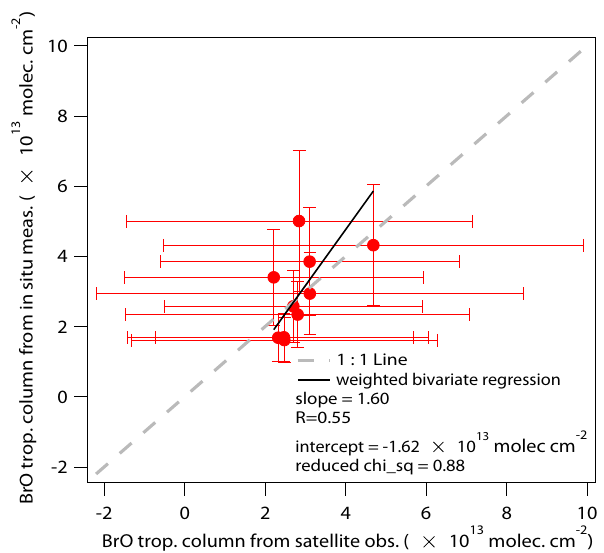
Fig. 5. Scatter plot of calculated BrO VCD from in situ measure- TROP ments along the flight track of flight on 17 April versus BrO VCD TROP from OMI satellite observations. The satellite columns are for pix- els closest in space and time to the aircraft profiles that resulted in the tropospheric columns (see text). Slope and intercept from weighted bivariate regression and the reduced chi-square are given.